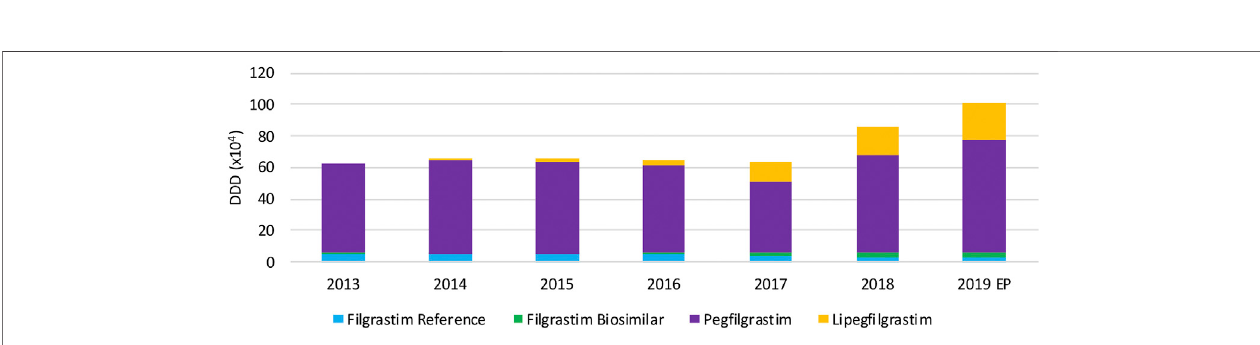
FIGURE 6 | Daily cost ( € per DDD) evolution of long-acting insulins between 2013 and 2019.